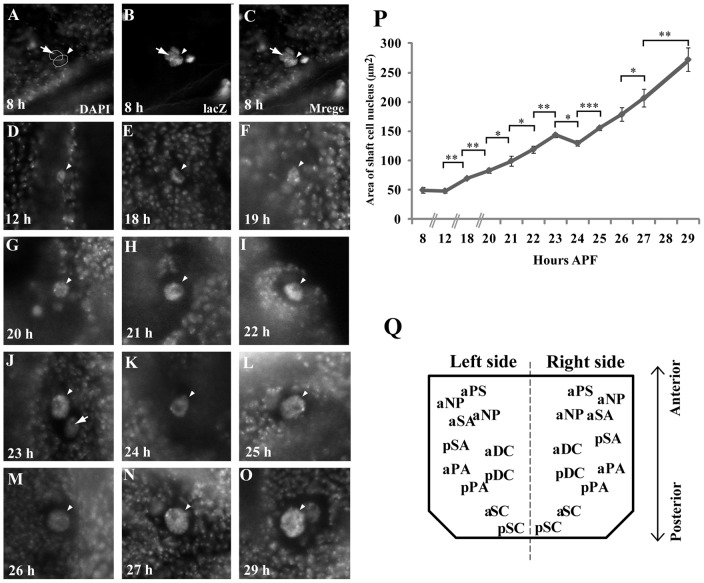
Dynamics of nuclear growth in pSC shaft cells from 8 to 29 hours APF.(A–O) Images of pSC shaft cells from 8 to 29 hours APF. Pupae with the A101-lacZ /+ genotype were grown till 8(n = 6), 12(n = 3), 18(n = 8), 20(n = 11), 21(n = 8), 22(n = 8), 23(n = 3), 24(n = 7), 25(n = 5), 26(n = 11), 27(n = 6), 29 hours APF (n = 7) and dissected thoraxes were stained with anti-lacZ and DAPI. Arrows indicate socket cell nuclei and arrowheads shaft cell nuclei. (P) Dynamics of nuclear growth in a pSC shaft cell from 8 to 29 hours APF. The Y axis indicates the section area of the shaft cell nucleus. Significant differences in mean values at each time point to those of adjacent time points were set at *P<0.05, **P<0.01 and ***P<0.001. (Q) Illustration of 22 macrochaetes on left and right sides of an adult thorax. pSC, posterior scutellar; aSC, anterior scutellar; pDC, posterior dorsocentral; aDC, anterior dorsocentral; pPA, posterior postalar; aPA, anterior postalar; pSA, posterior supraalar; aSA, anterior supraalar; pNP, posterior notopleural;, aNP, anterior notopleural; PC, presutural.